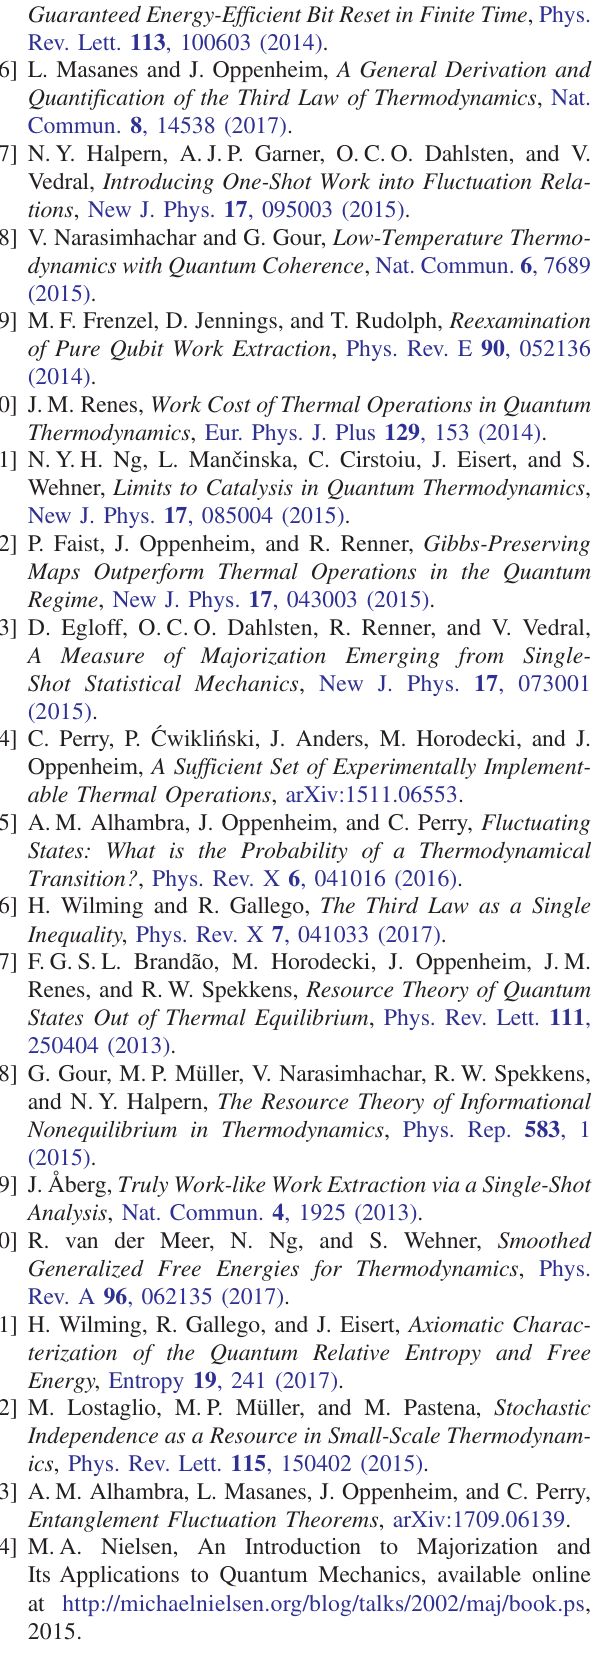
Algorithmic Cooling Using Solid-State Nuclear Magnetic Resonance , Nature (London) 438 , 470